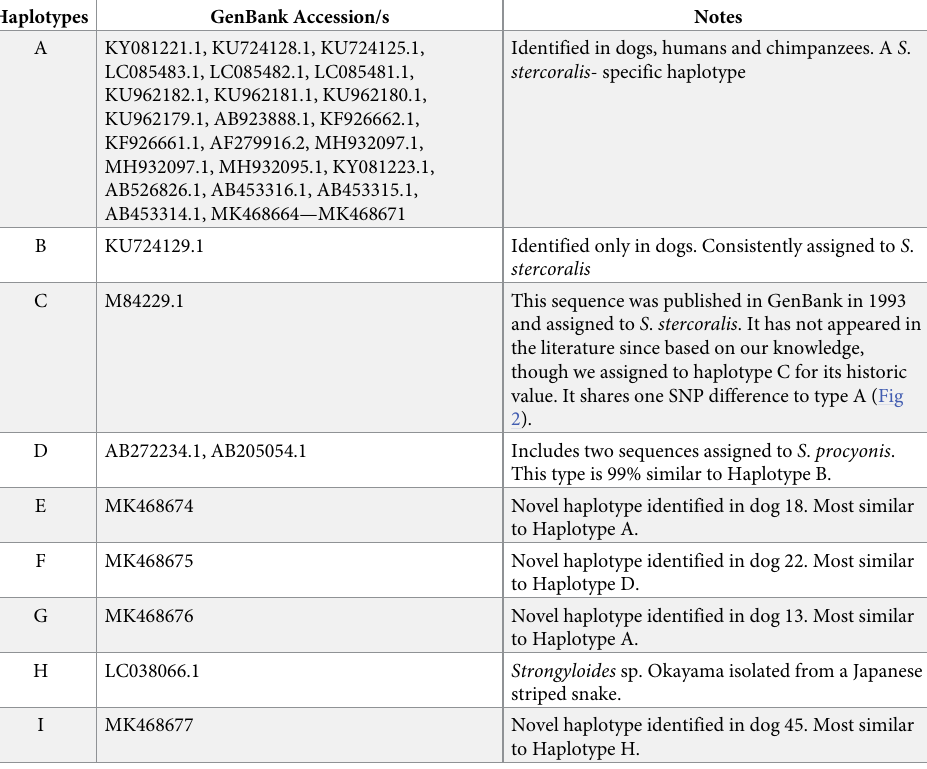
Table 3. HVR IV haplotypes assigned to Strongyloides sp. based on current